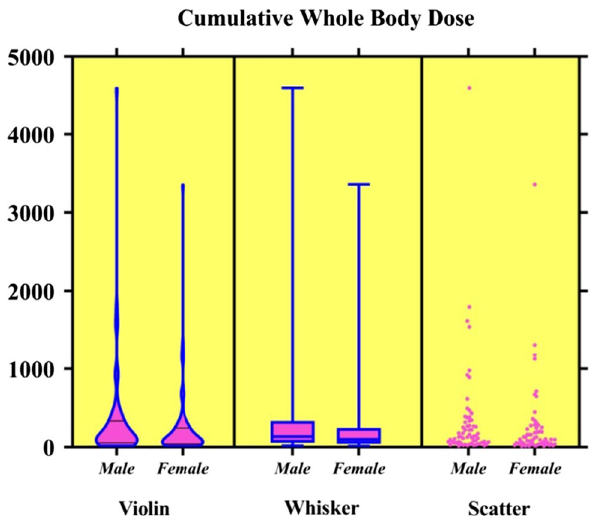
whole body radiation dose, cumulative whole body dose and excess cancer risk were calculated to assess the radioactive risk. To study the distribution of parameters in the samples, Violin, Whisker and Scatter plots were drawn. Using Surfer spatial contour maps for each parameter were plotted. Each parameter was compared with the limits of safety specified by different agencies.